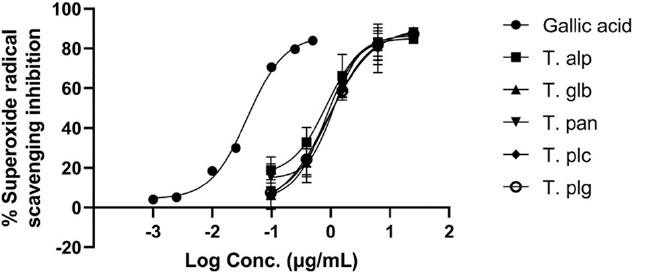
Figure 3. The concentration (expressed as logC, in μ g/mL)-dependent antioxidant activity of Thymus extracts and gallic acid against superoxide radical generated by the xanthine/xanthine oxidase method. T. alp — T. alpestris , T. glb — T. glabrescens , T. pan — T. pannonicus , T. plc — T. pulegioides , T. plg — T. pulcherimus